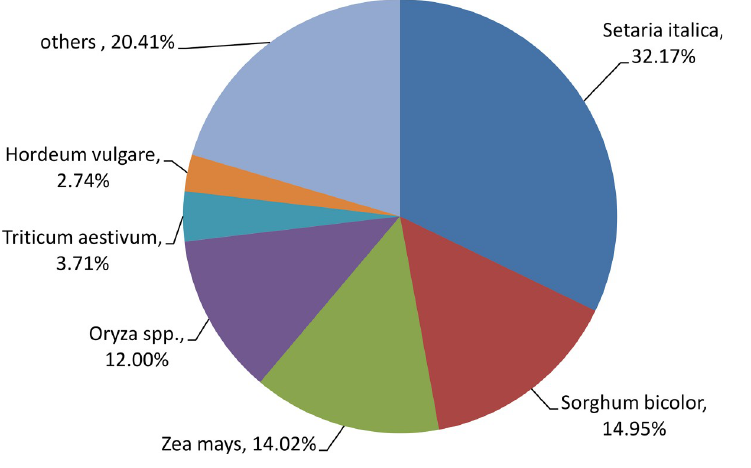
Fig 2. Similarity of Manila grass sequences with those of other species.